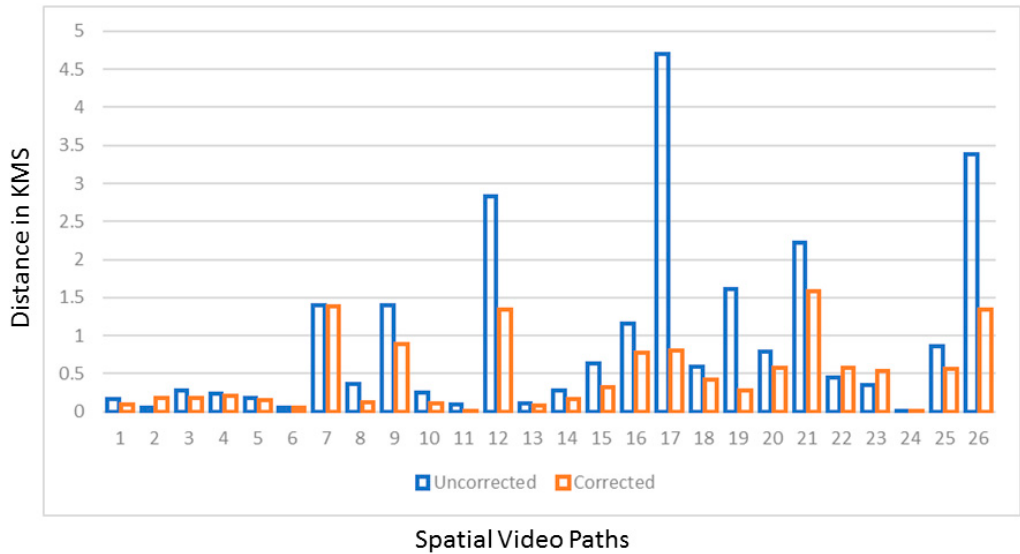
Figure 4. The variations in lengths of paths before and after correction. In most instances the original GPS path is shorter (in four cases less than half the length). This variation is mostly due to the signal bouncing between surfaces leading to a distance overestimation. The few instances where the corrected path is longer (22 and 23) are because the software allowed for the re-creation of the GPS path where the original signal was lost.